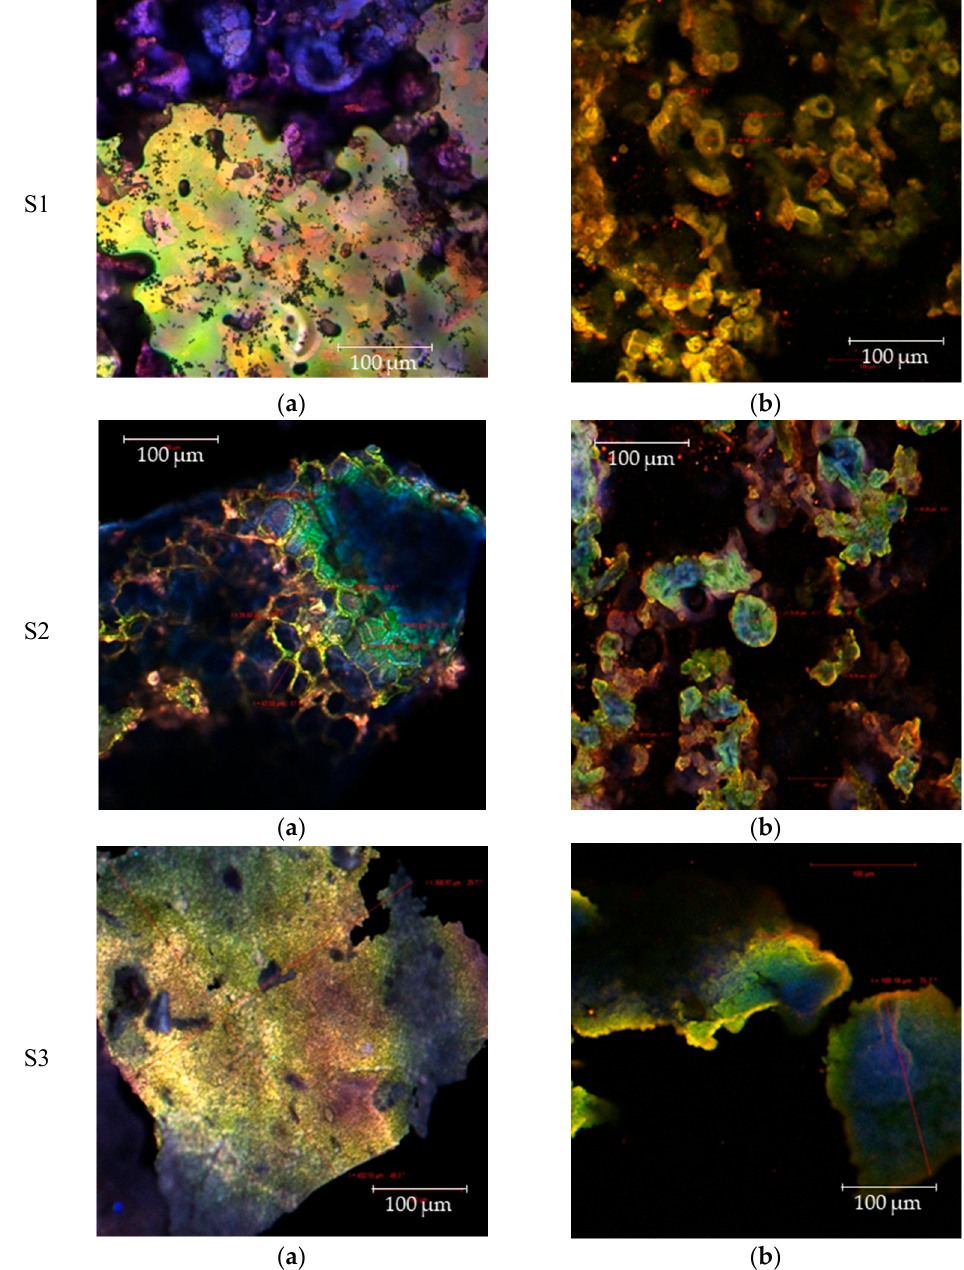
Figure 3. Confocal microscopy images acquired for the native powders ( a ) and for the fluorophore dyed powders ( b